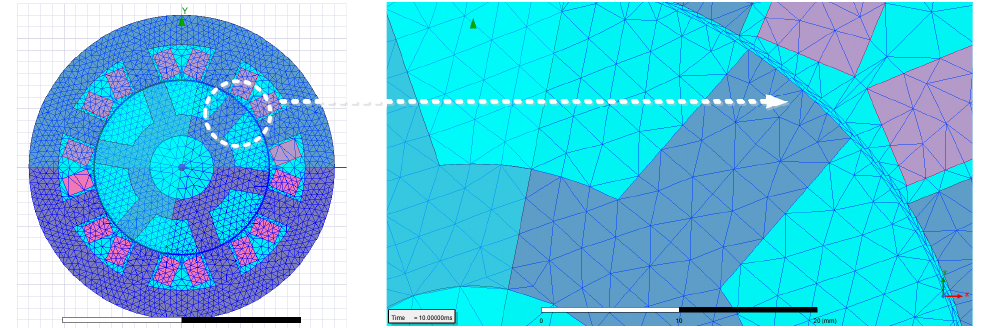
Figure 15. Meshing of the optimized model. A zoomed-in view is also provided for improved mesh detail.